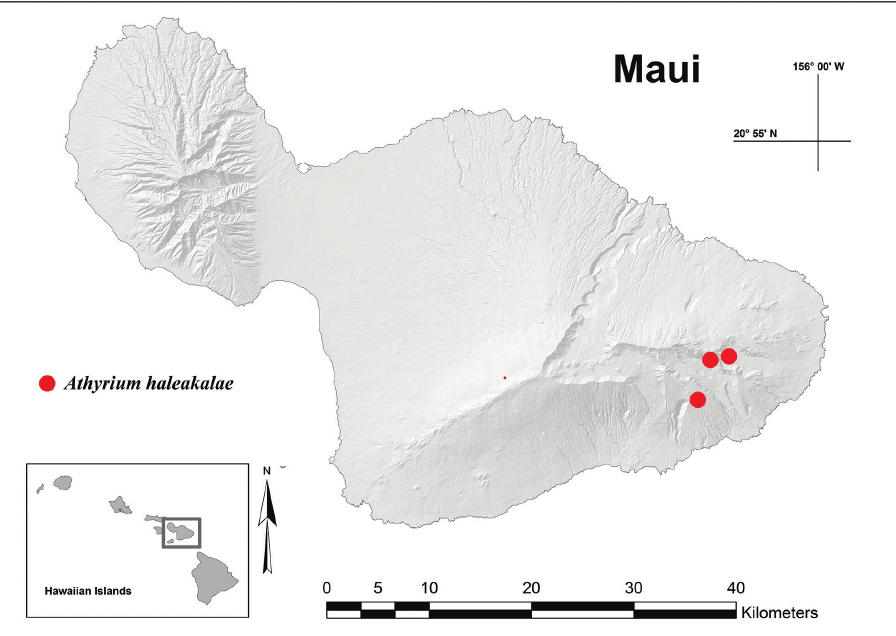
Figure 2. Map showing known distribution of Athyrium haleakalae , East Maui, HI, with upper right red dot indicating colonies in the headwaters of Kawakoe and Mokulehua, upper left in Helele‘ike‘oha, and lower red in Kīpahulu, near